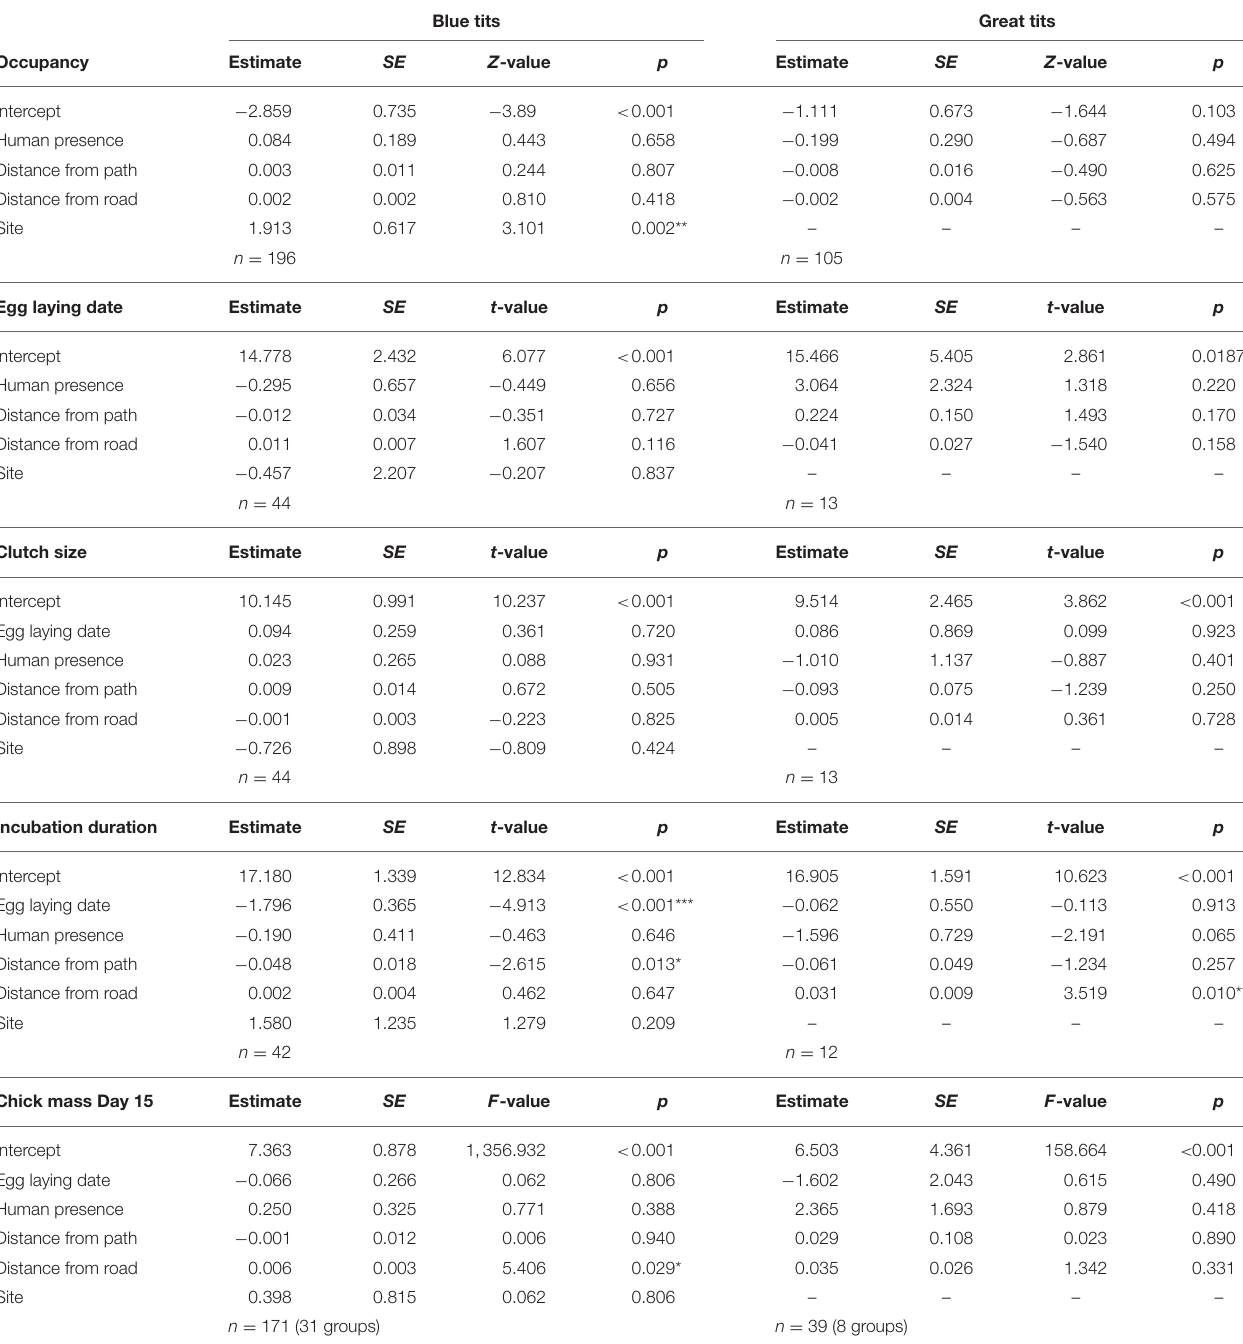
TABLE 5 | Effects of human presence, paths and roads on blue tit and great tit reproductive traits.